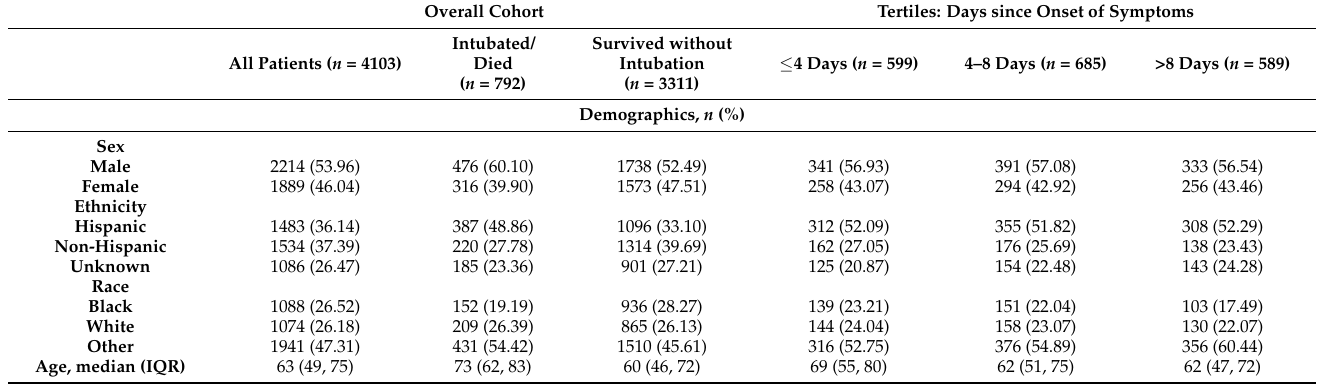
Table 1. Demographic and clinical characteristics of patients diagnosed with COVID-19 overall and by duration from symptom